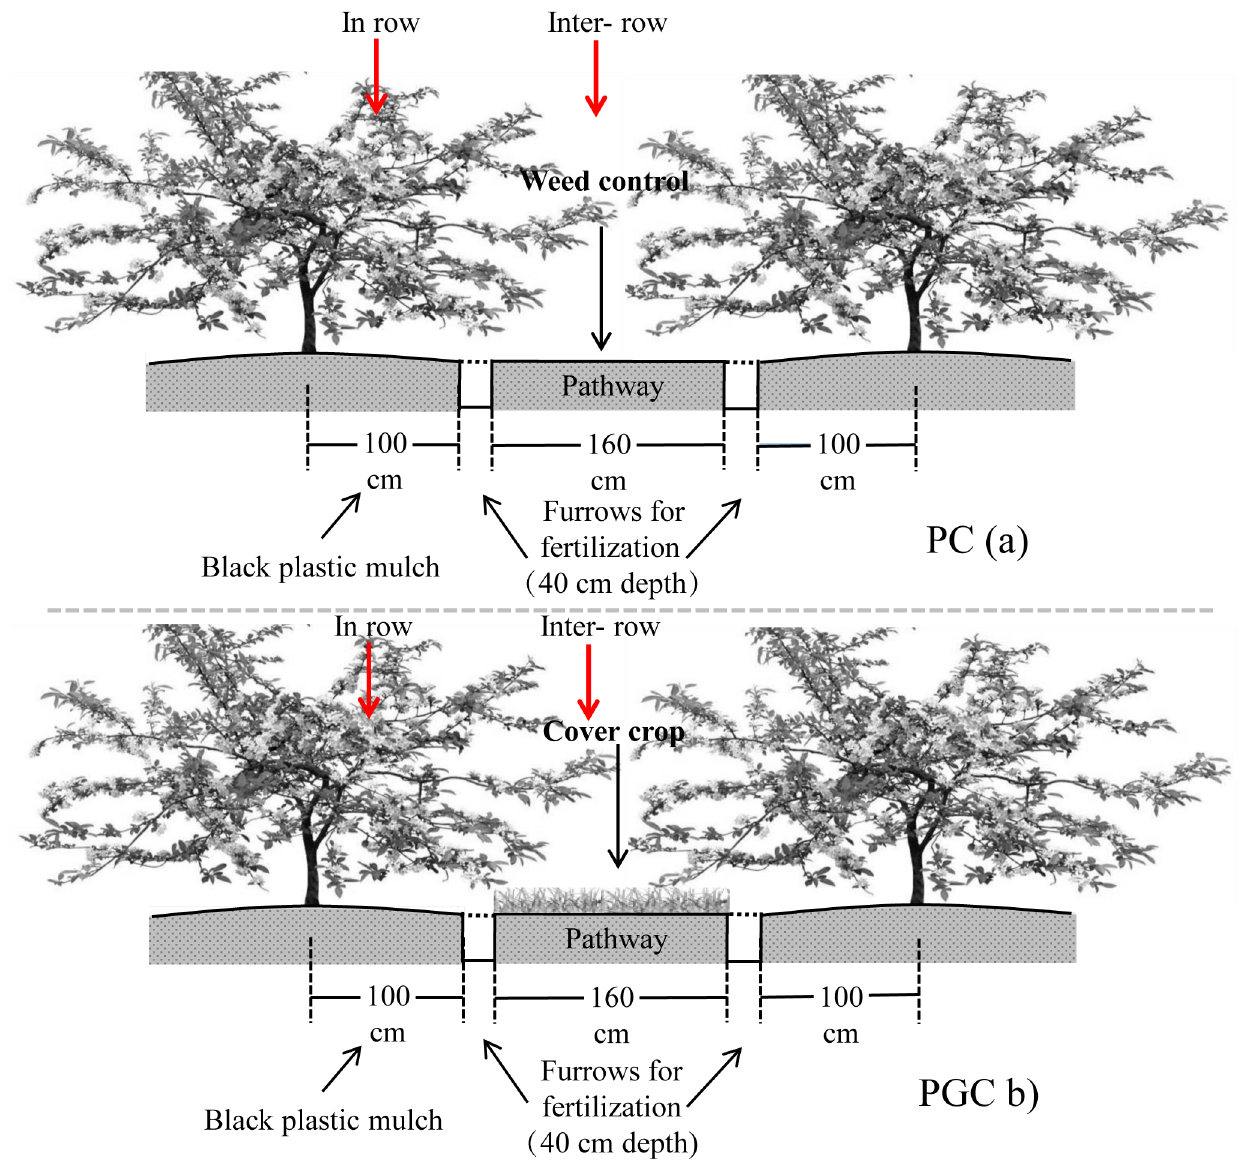
Fig 3. Schematic view of PC (black plastic mulch with weed control) and PGC (black plastic mulch combined with cover crop)